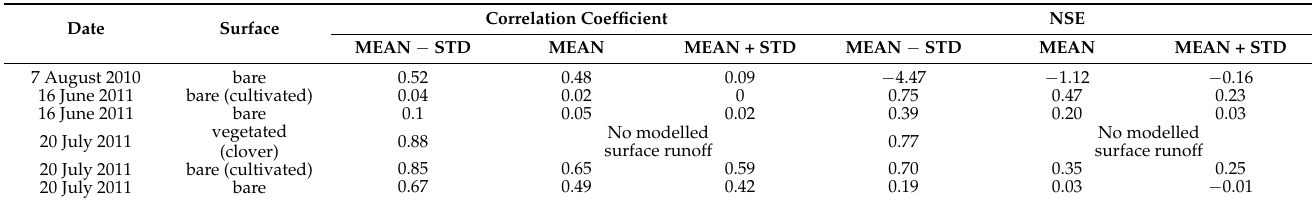
Table 4. The overview of the episodes used for field-scale rill flow validation.